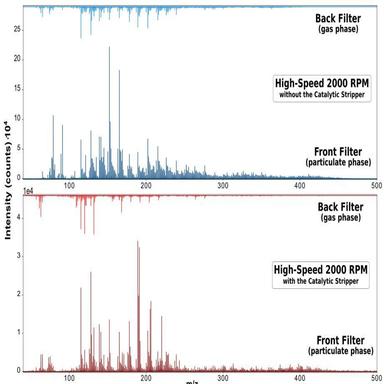
Mass spectra of HSFF/BF and HS CSFF/BF samples (particulate and gas phase collected with and without the CS) obtained with L2MS.